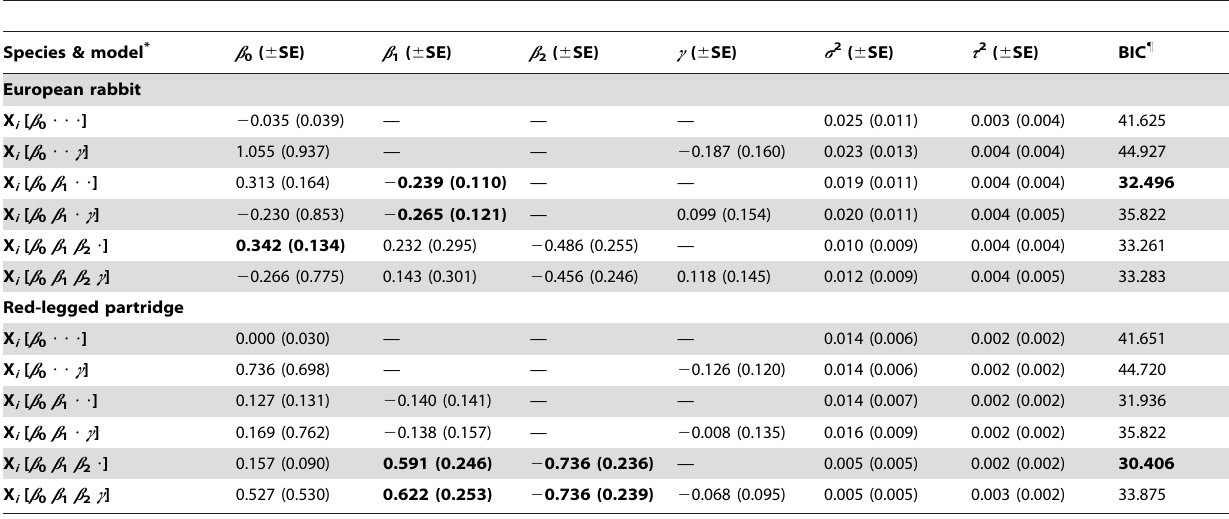
Table 1. Posterior estimates for the parameters in the Gompertz state-space model (eqns. 1–3), obtained for both prey species through Markov chain Monte Carlo integration.